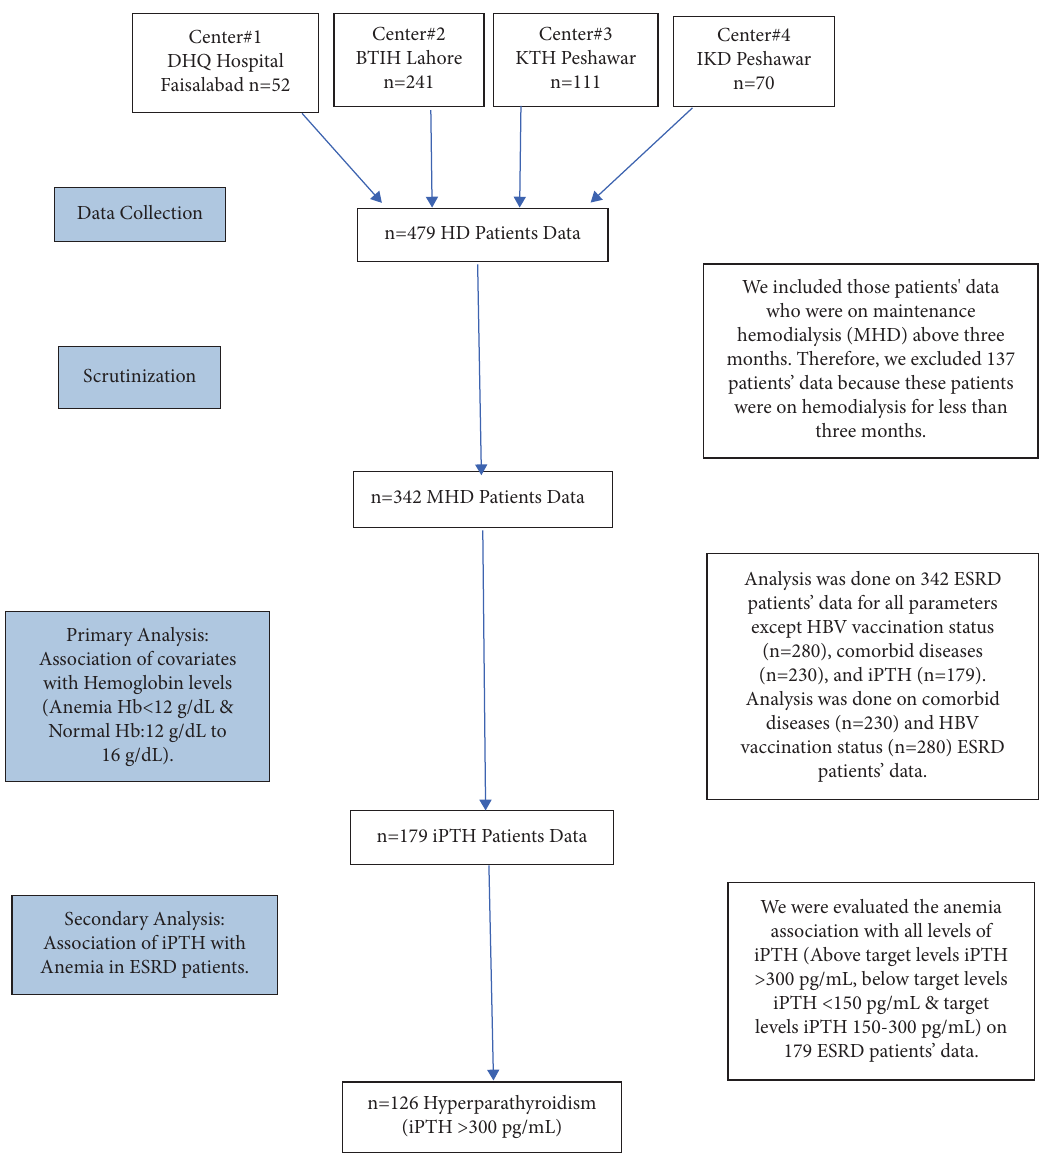
Figure 2: Flow diagram of data collection and scrutinization of end-stage renal disease ESRD patients’ data. DHQ: District Headquarter; BTIH: Bahria Town International Hospital; KTH: Khyber Teaching Hospital; IKD: Institute of Kidney Diseases; HD: hemodialysis; MHD: maintenance hemodialysis; iPTH: intact parathyroid hormone; ESRD: end-stage renal disease; Hb: hemoglobin; HBV: hepatitis